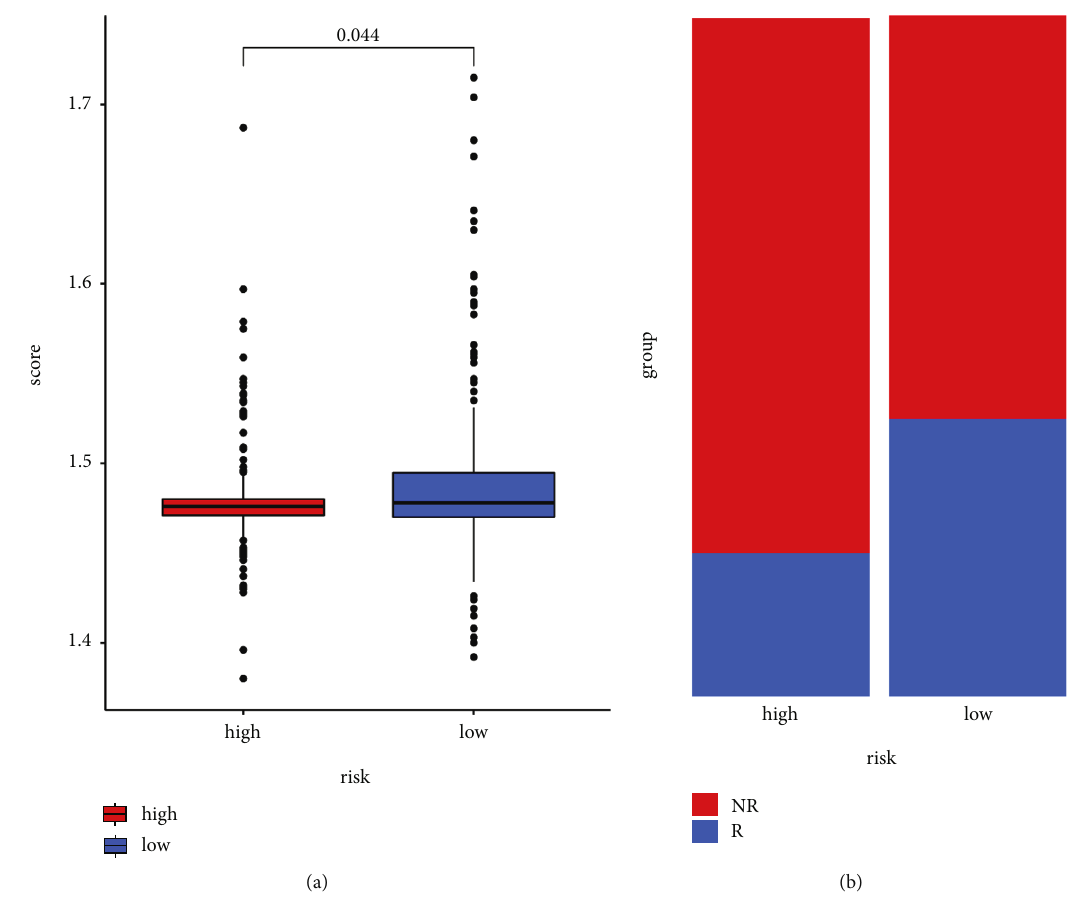
Figure 9: Response to immunotherapy in high- and low-risk groups. (a) Scores for immune responses in two groups. (b) Proportion of immune responses in two